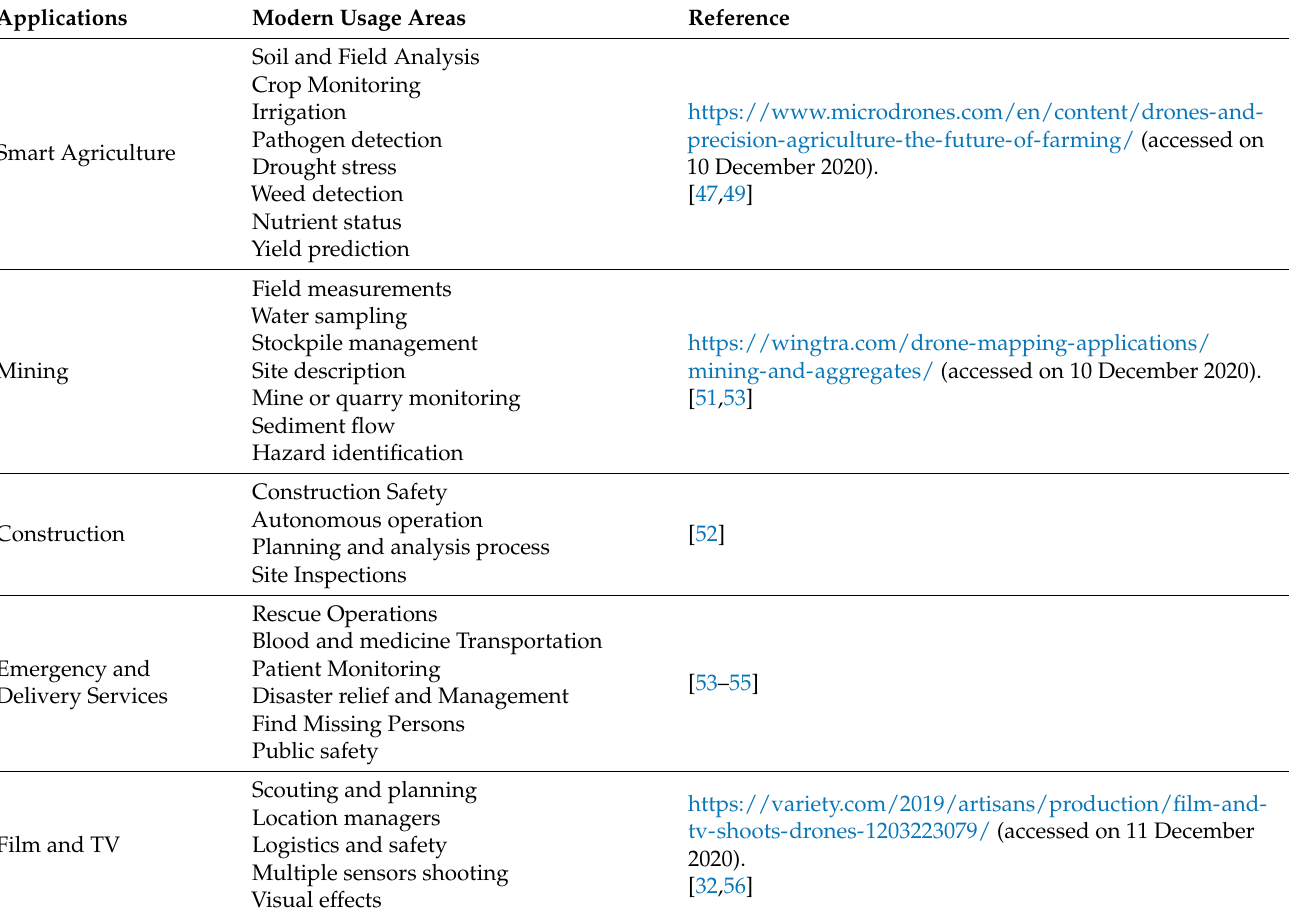
Table 2. Summary of drone applications and their modern usage